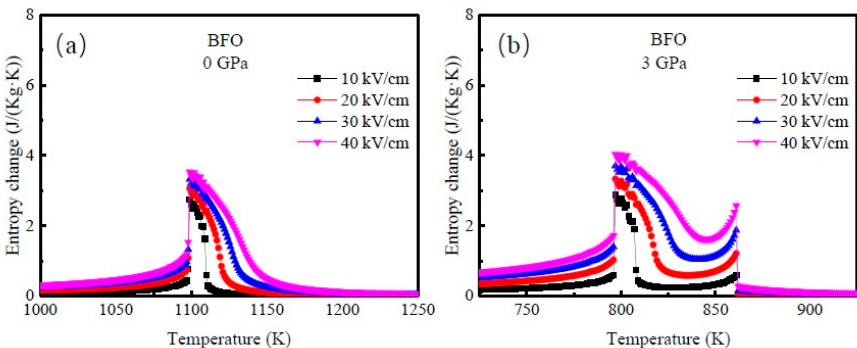
Figure 4. Entropy changes of BFO with different electric fields as a function of temperature under ( a ) ( a ) 0 GPa and ( b ) 3 0 GPa and ( b ) 3 GPa.